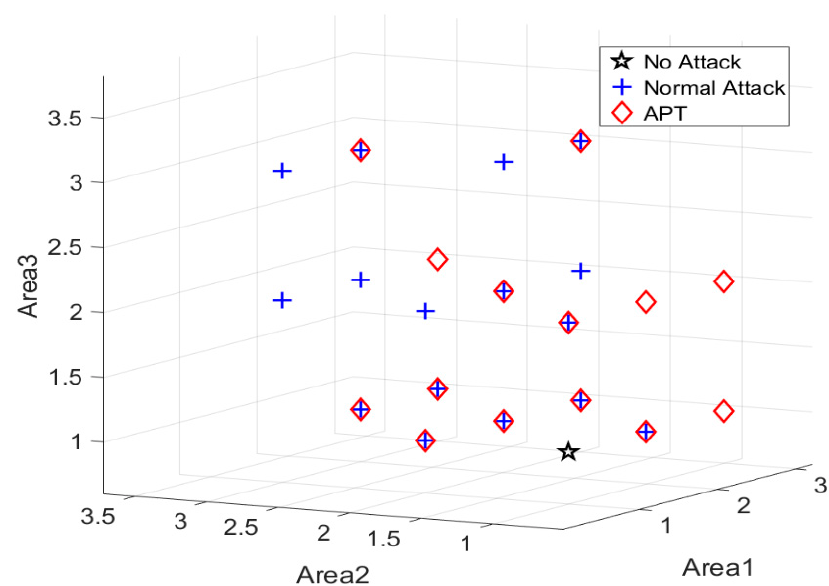
Figure 7. The area difference.